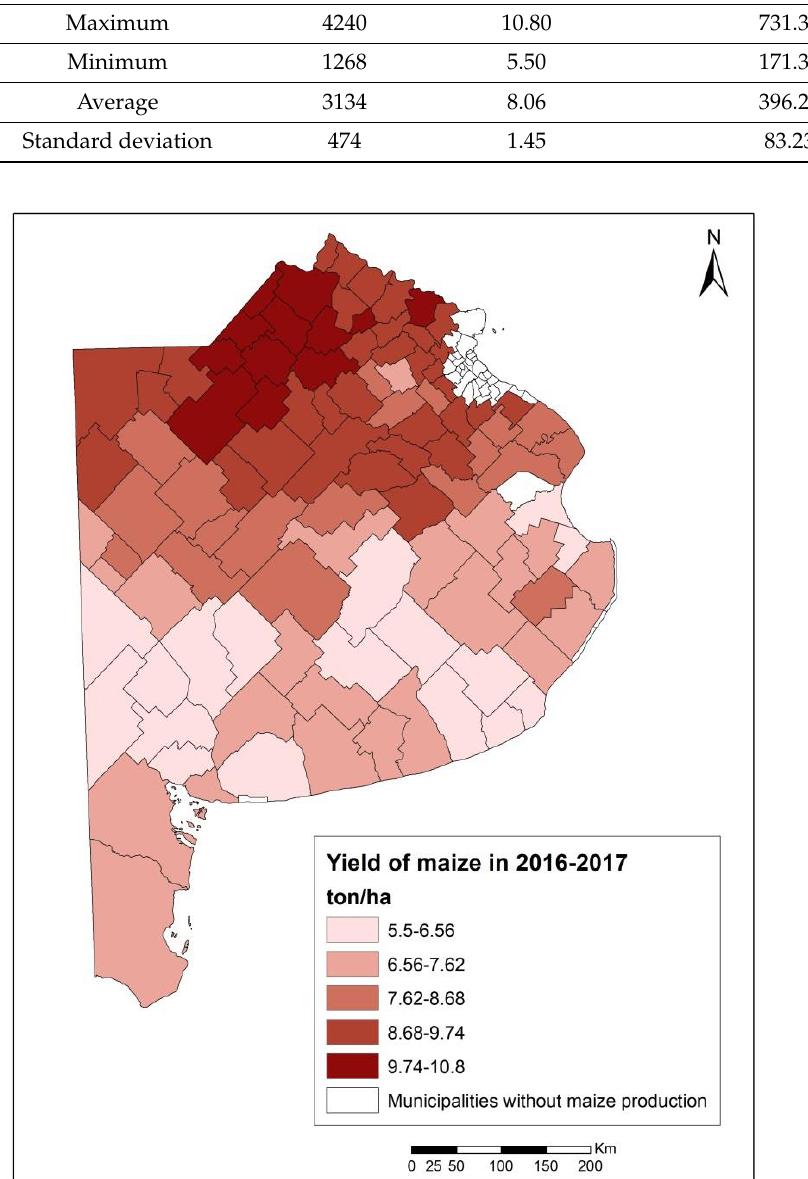
Figure 4. Yield of maize in 2016–2017 at the municipality level in Buenos Aires province (tons/ha).